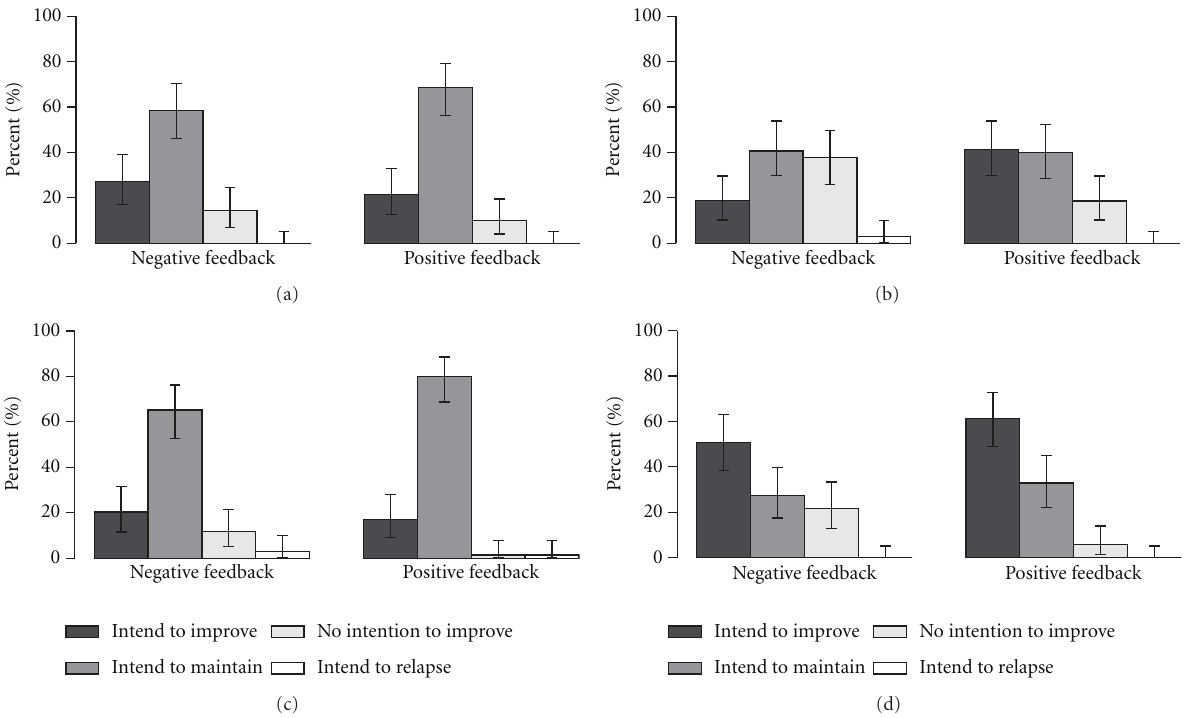
Figure 2: Changes in intentions regarding sun protection and screening (pretest-posttest). (a) Sunscreen use. (b) Shade seeking. For sunscreen use and shade-seeking outcomes, intend to improve is indicated by lower pretest utilization (never, sometimes) and higher posttest intentions (often or always). Intend to maintain is indicated by higher pretest utilization (often or always) and higher posttest intentions (often or always). No intention to improve is indicated by lower pretest utilization (never, sometimes) and lower posttest intentions (never, sometimes). Finally, intend to relapse is indicated by higher pretest utilization (often or always) and lower posttest intentions (never, sometimes). (c) Skin cancer screening by a healthcare professional. (d) Skin cancer self-screening. For screening outcomes, intend to improve is indicated by no reported prior screening at pretest but intentions to screen at posttest. Intend to maintain is indicated by reported prior screening at pretest and intentions to screen at posttest. No intention to improve is indicated by no reported prior screening at pretest and no intentions to screen at posttest. Intend to relapse are indicated by reported prior screening at pretest, yet no intentions to screen at